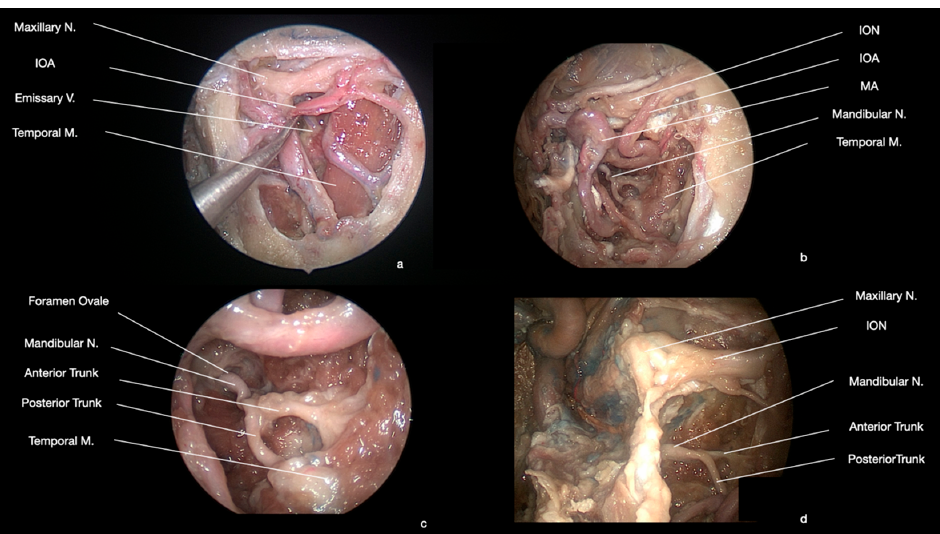
Figure 4. Anatomical endoscopic endonasal dissection (0° degree scope). (A: artery, V: vein, M: muscle, N: nerve, ION: infraorbital nerve, IOA: infraorbital artery, MA: maxillary artery). ( a , b )The mandibular nerve (V3) is contained in the ITF. ( c , d ) Immediately after its exit from the foramen ovale, it divides into a smaller anterior and a larger posterior trunk.